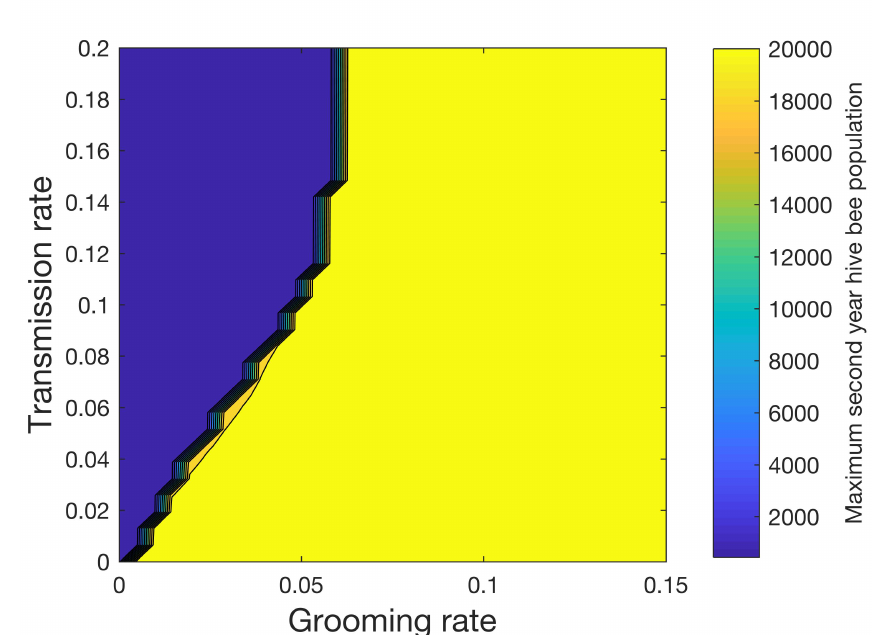
Figure 8. Effect of grooming rate γ and transmission rate β (10)–(13) on the second year maximum hive bee population. The transmission rate models the rate at which uninfested bees become infested. The grooming rate models the rate at which infested bees becomes uninfested. A sharp line divides the conditions under which the colony can be sustained (yellow) versus when the colony perishes